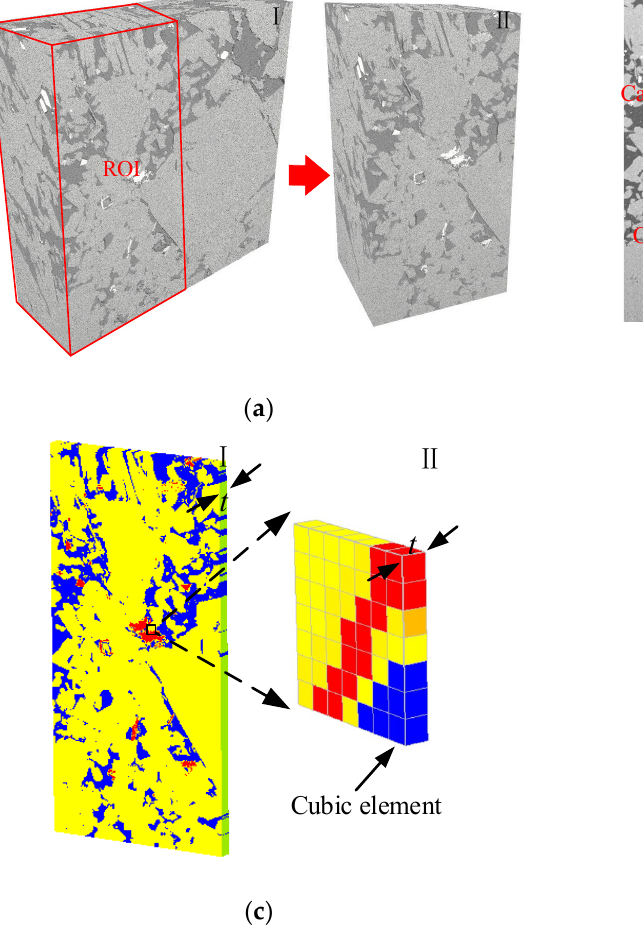
Figure 4. Reconstruction of 3D numerical models by digital image processing. ( a ) Getting the picture of the study model. ( b ) Determination of segmentation threshold. ( c ) A layer generated with a vertical extension of a slice image (Vectorization). ( d ) The 3D image stacking and numerical reconstruction model of shale specimens.